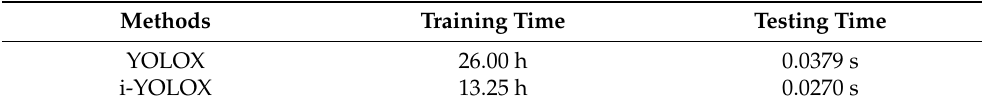
Table 4. Training time and testing time.